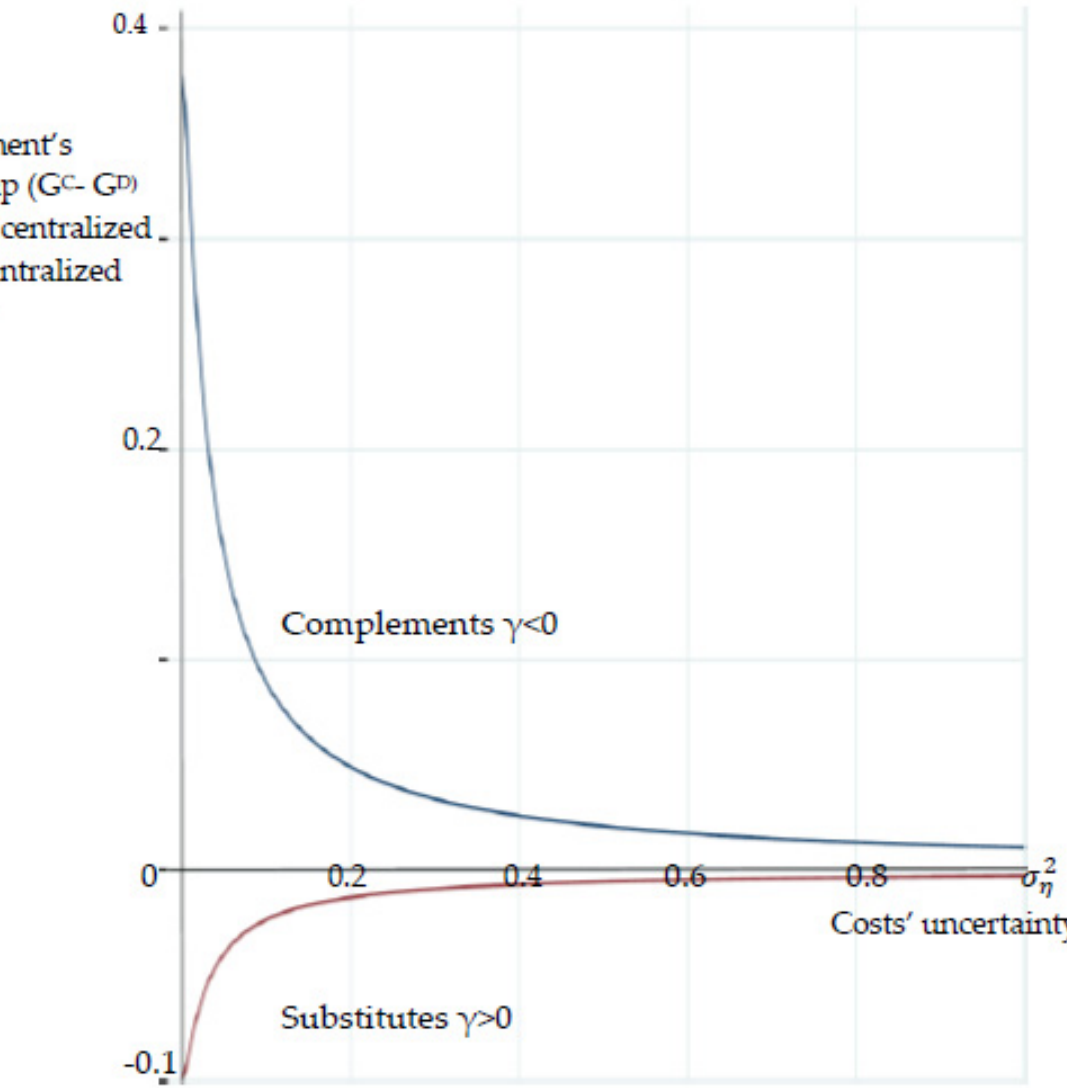
Figure 1. Government utility gap under substitutes ( γ > 0) and complements ( γ < 0). Note: The figure is for illustrative purposes only, as it assumes fixed values of the parameters: α = 2, β = 1, η = 1.2, and γ = ± 0.5. However, the result is generalized for the set of parameters satisfying regularity conditions. The government prefers bureaucratic centralization for G C − G D > 0 and decentralization for G C − G D < 0. Centralization is preferred with complements, γ < 0; decentralization with substitutes, γ > 0.